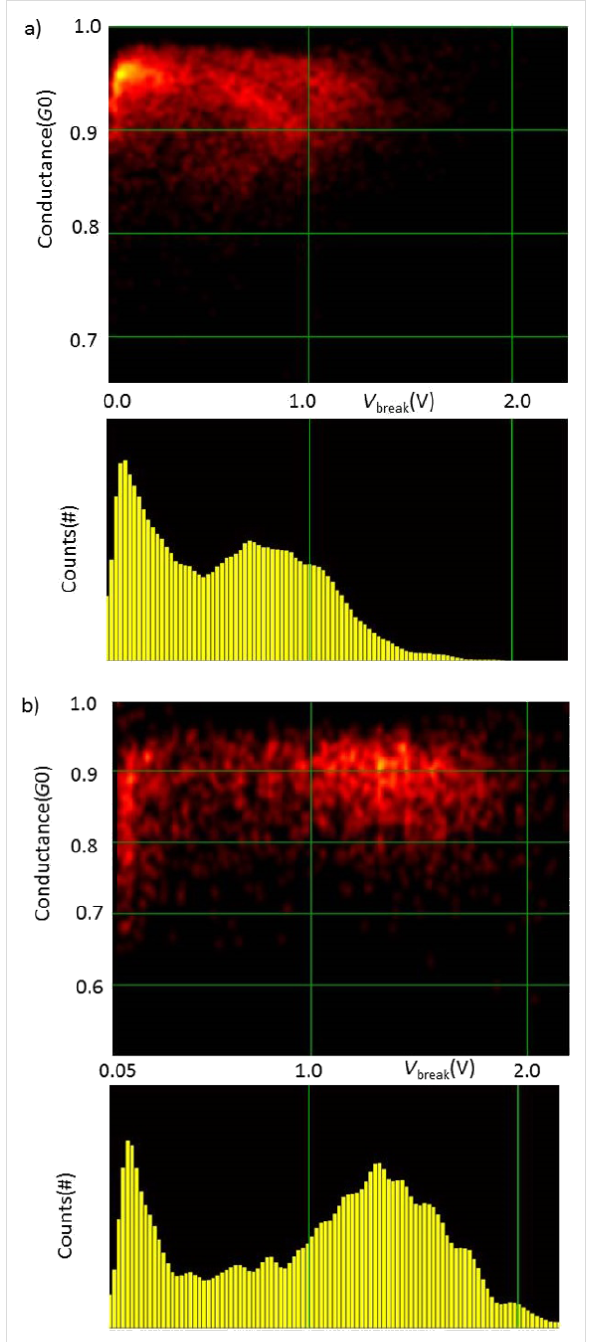
Figure 5: (a) Density plot (top panel) and histogram (lower panel) collecting all breaking voltages for all chain lengths for Au at 10 mV preparation voltage, as obtained from the data in [10]. (b) Density plot (top panel) and histogram (lower panel) collecting all breaking volt- ages for all chain lengths for Au at 50 mV preparation